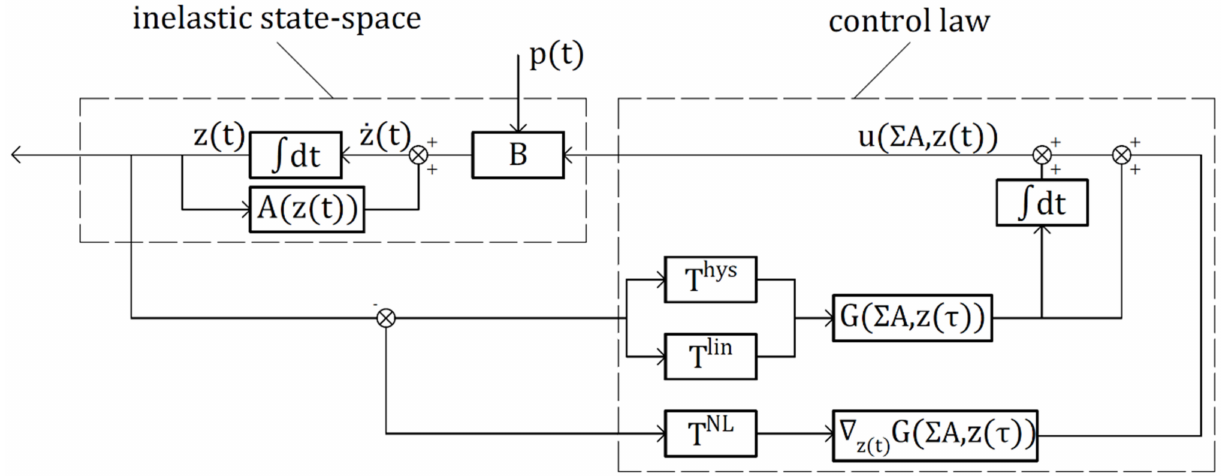
Figure 3. Proposed state-space paradigm.